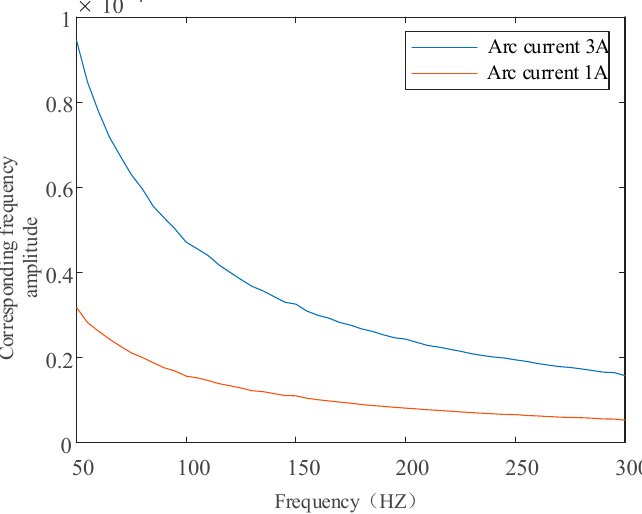
Figure 6. The DC arc current spectrum. The arc resistance current depends on the arc voltage. During simulation, the arc current was affected mainly by the grounding point in series with the arc resistance. The fault time was 3 s, the arc resistance ground connection was 100 ohm, the fault distance was 1 km, and the interaction voltages were 160 and 200 V. The amplitude and frequency characteristics of the normal and line currents grounded by the arc resistance are shown in Figure 7.